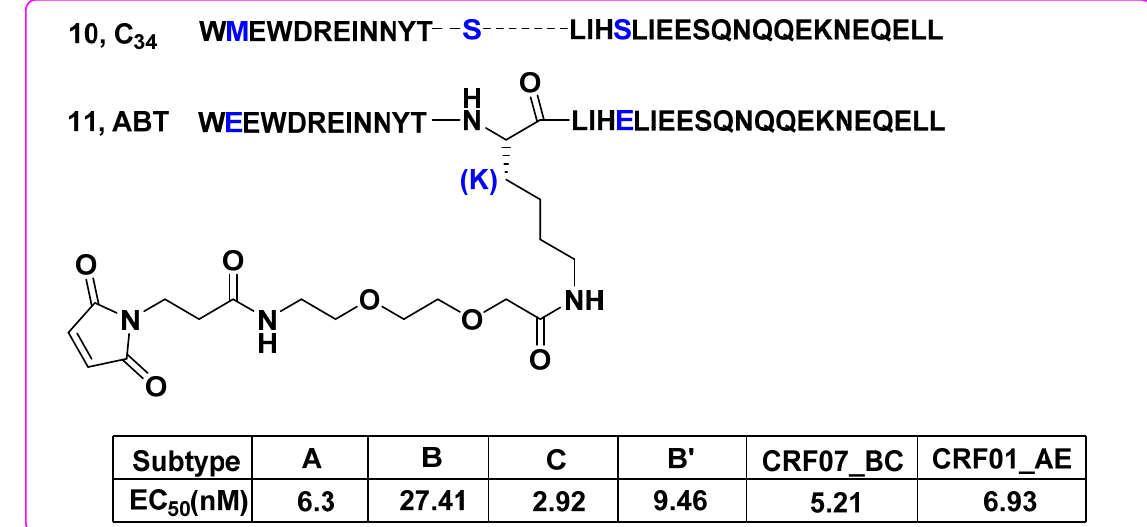
Figure 7. The discovery of ABT and inhibitory potency against a set of HIV-1 subtypes [34].